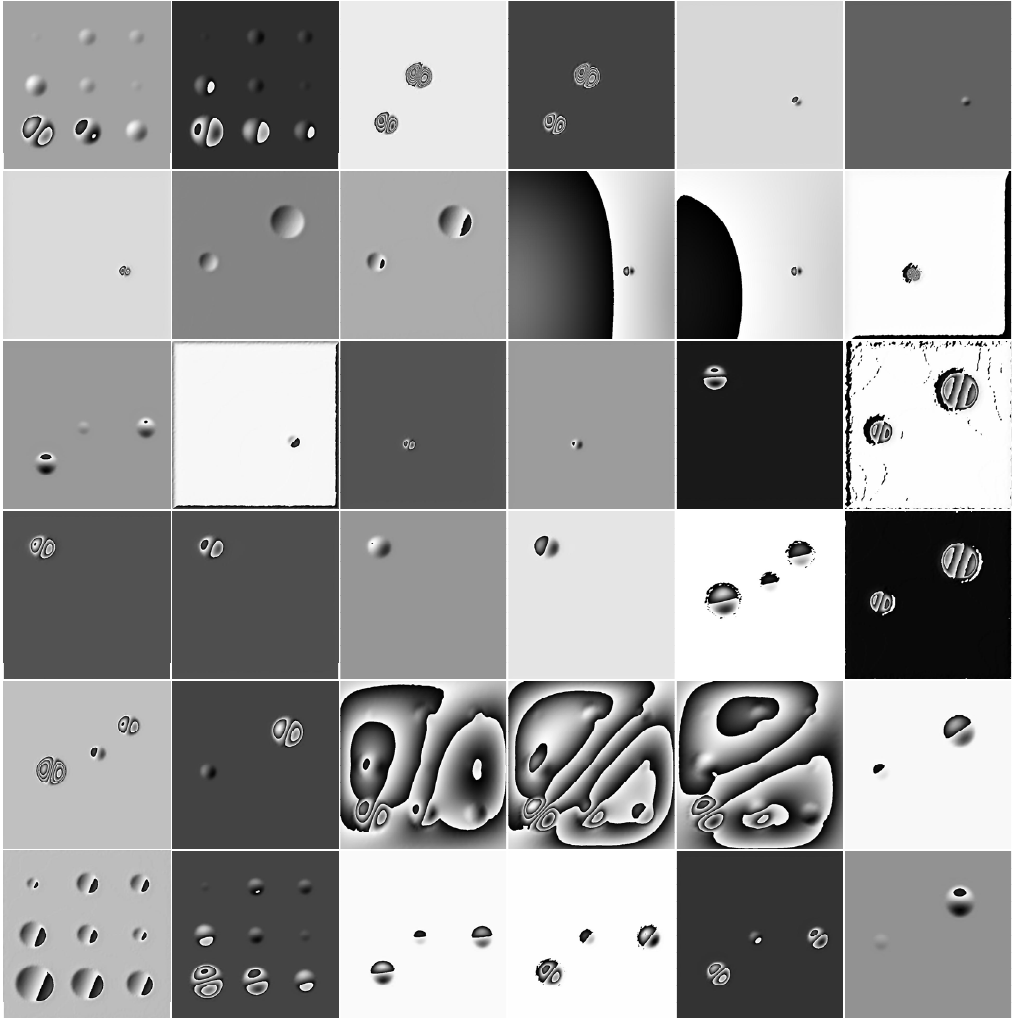
Figure 7. Part of the simulated dataset.